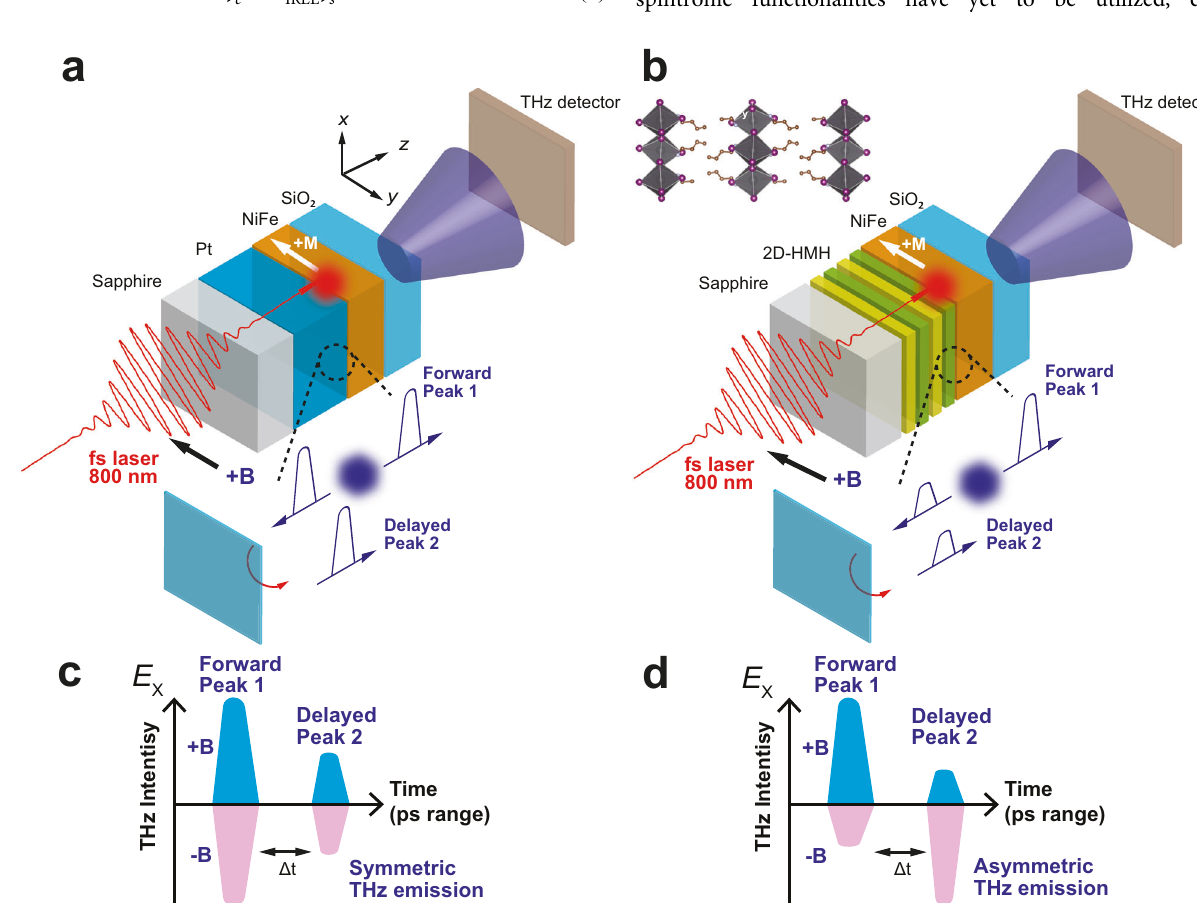
Fig. 1 Schematic illustration of spintronic-THz emission in Pt/NiFe and 2D-HMH/NiFe heterostructures. a A sketch of metallic-based spintronic-THz emission in a Sapphire/Pt/NiFe heterostructure. Under fs laser excitation, the superdiffusive spin current injects into the nonmagnetic metallic layer (e.g., Pt) and produces substantial THz radiation via an ef fi cient spin-to-charge conversion process. Generated THz radiation propagates toward the forward ( + z , i.e., forward peak 1) and backward ( − z ) direction evenly. The backward THz radiation is re fl ected at the interface between the sapphire substrate and air, generating a delayed THz signal (delayed peak 2) collected by the THz detector ( Δ t = t 1 − t 2 ~10-11 picoseconds). b Schematic structure of the hybrid spintronic-THz emitter using layered 2D-HMH materials and magnetic fi eld-dependent THz radiation from the metallic spintronic-THz emitters along the x-direction in the picosecond timescale. The phase of THz emission depends on the magnetization of the NiFe. c, d The illustrated symmetric and asymmetric THz radiation under fs laser excitation, respectively. An asymmetric THz radiation emits toward + z and − z direction, of which the intensity is controlled by the applied external magnetic fi eld. The top-left panel in b shows the schematic crystal structure of prototypical 2D-HMH materials, i.e., two- dimensional (BA) 2 PbI 4